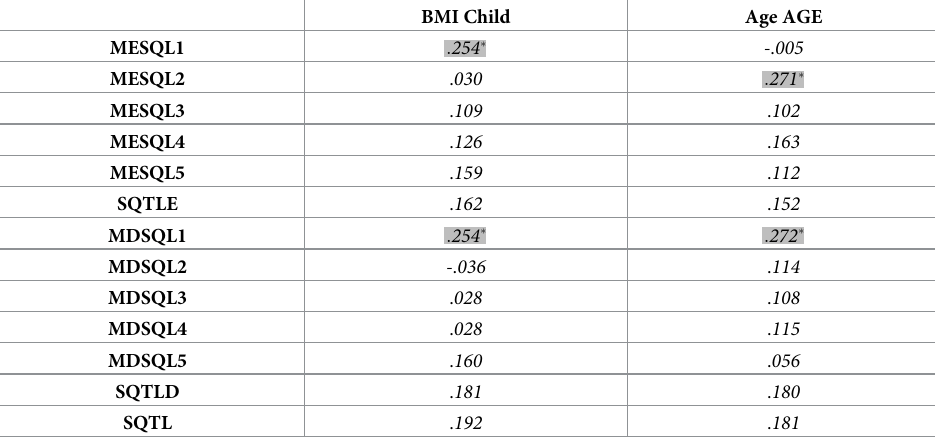
Table 2. Correlation between number of ridges on the fingers, BMI child, and age at beginning of pregnancy of the mother (AGM age) both genders.